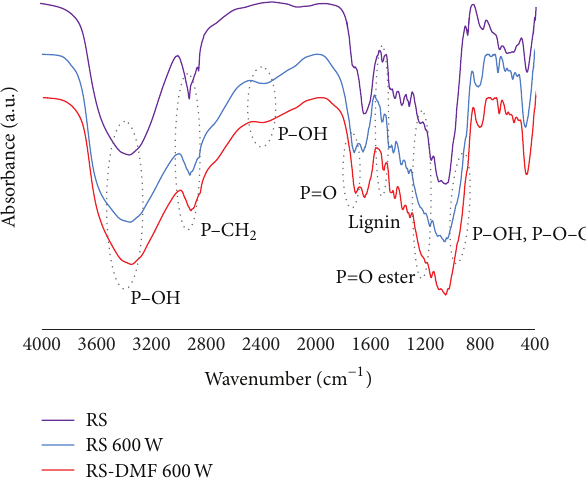
Figure 3: IR spectra of unmodified rice straw (RS), modified rice straw (RS 600 W), and RS-DMF 600 W.